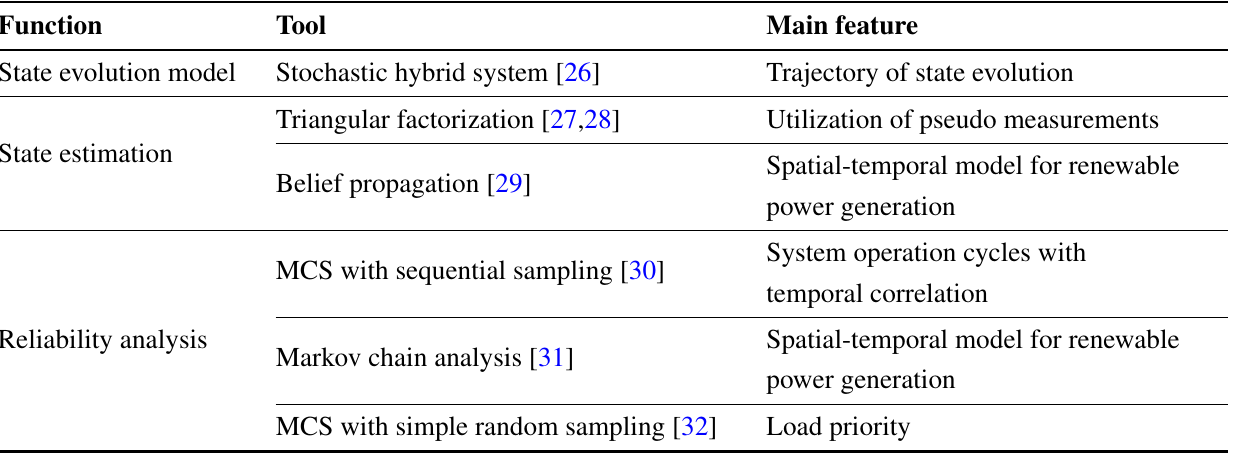
Table 1. Stochastic models of a microgrid. MCS, Monte Carlo